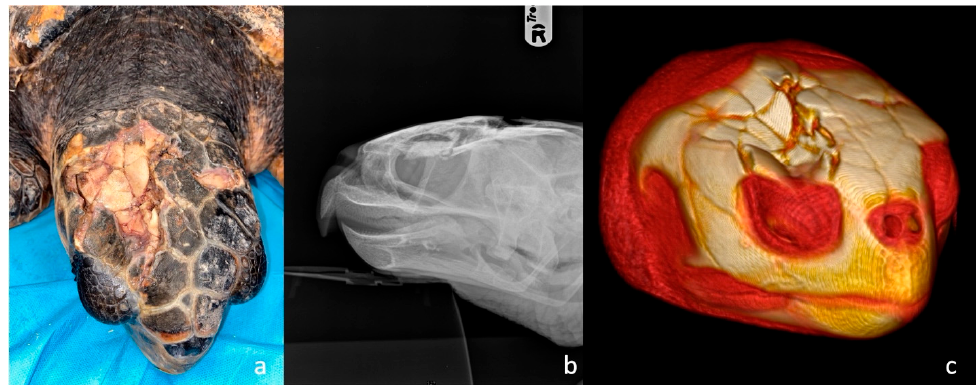
Figure 1. Head trauma staging example ( a ) Clinical assessment of a grade 3 skull trauma; ( b ) X-ray in latero-lateral view showing parietal and postorbital fractures; ( c ) 3D-CT scan of the same turtle’s skull showing the same clinical pattern and the compromised right ocular globe.